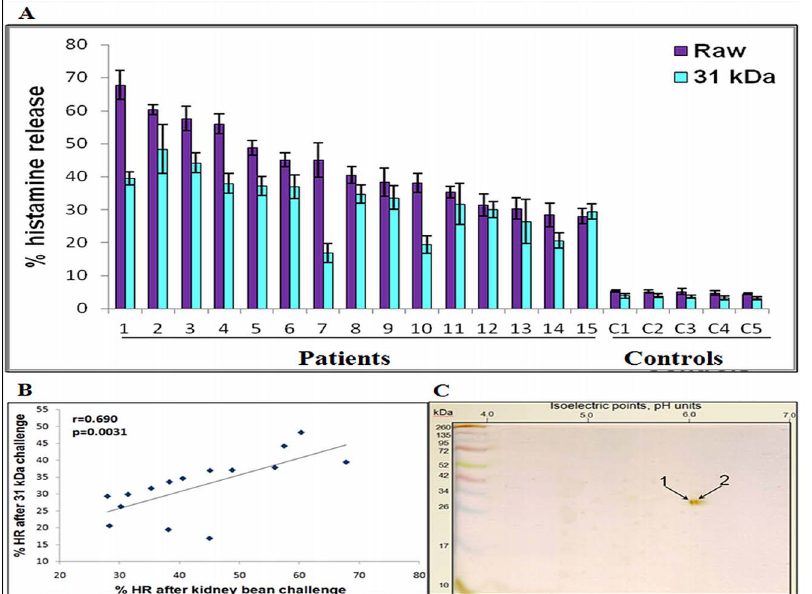
Figure 3. Histamine released from stripped basophils re-sensitized with individual patients’ sera (n=15) on challenge with kidney bean extract and 31 kDa purified protein, separately. Lane C1 2 C5: controls (A). Scatter plot of the correlation analysis between % histamine released by patients (n=15) and controls on challenge with crude kidney bean extract and purified protein (B). 2-DE of purified 31 kDa protein showing two close spots (1 & 2) at the same molecular weight. Both the spots were identified as PHA-E after mass spectrometric analysis (C).